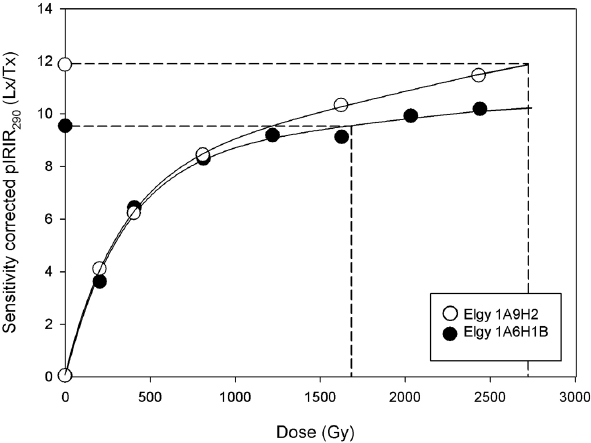
Fig. 7. Dose response curves of the pIRIR 290 protocol applied to polymineral fine grain extracts of sample 1A6H2B and 1A9H2. The data is best fitted to a single exponential plus linear (SEPL) func- tion. Although sample 1A6H1B is much younger than 1A9H2, the linear part of the DRC is less steep and slowly approaching the sat- uration level. This results in large errors and substantially limits the precision of pIRIR 290 D e determination.